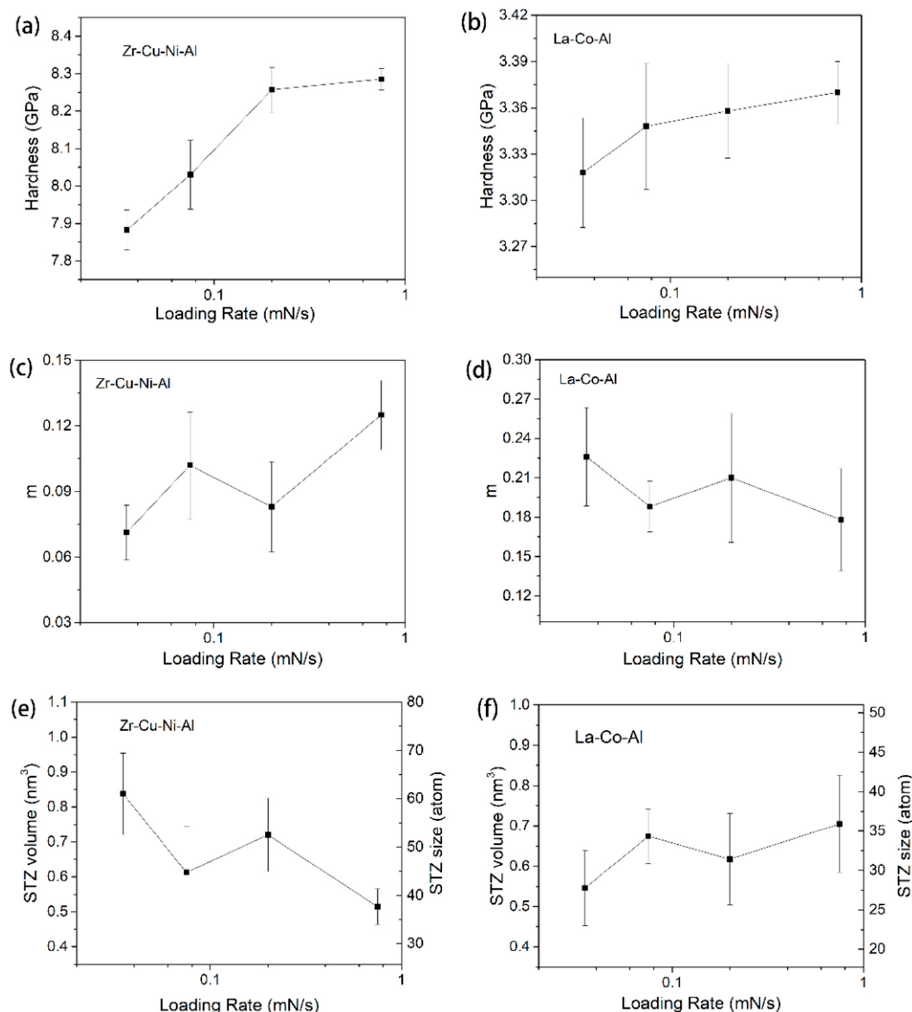
Figure 7. Typical creep displacements versus holding time with four different loading rates at the initial holding depth of 200 nm for ( a ) Zr-Cu-Ni-Al and ( b ) La-Co-Al; the creep curves could be perfectly fitted.